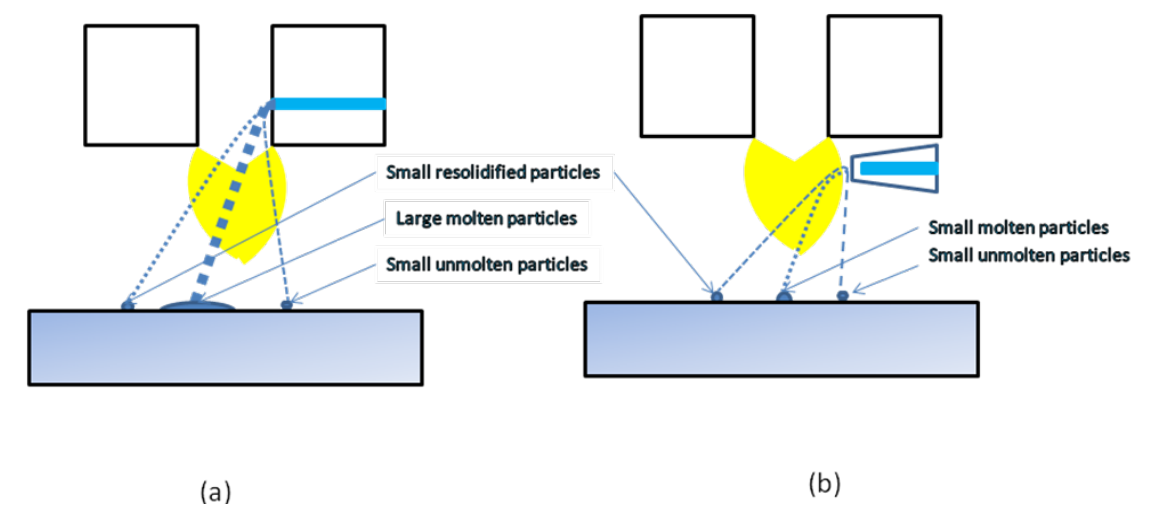
Figure 17. Possible trajectories of droplets/particles during plasma spraying with the use of internal, continuous-stream injection (a) and external, atomizing injection